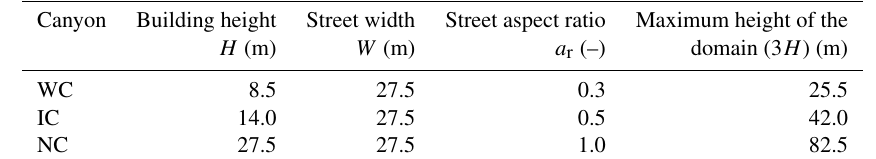
Table 1. Characteristics of the three canyons studied.